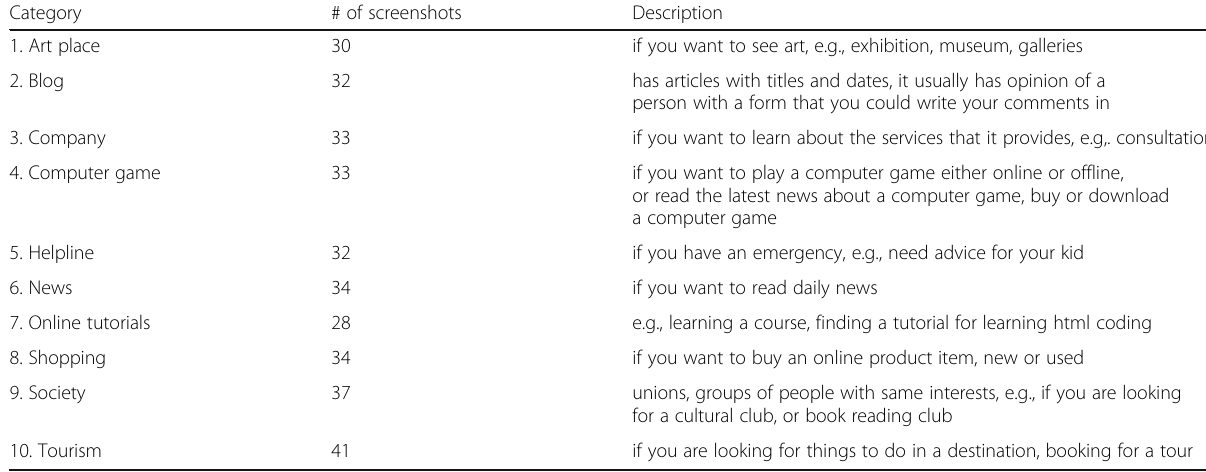
Table 1 Selected web page categories and their descriptions. This is identical to the list that was given to subjects, and was designed to be intuitive. Each subject could consult this list at any time during the experiment